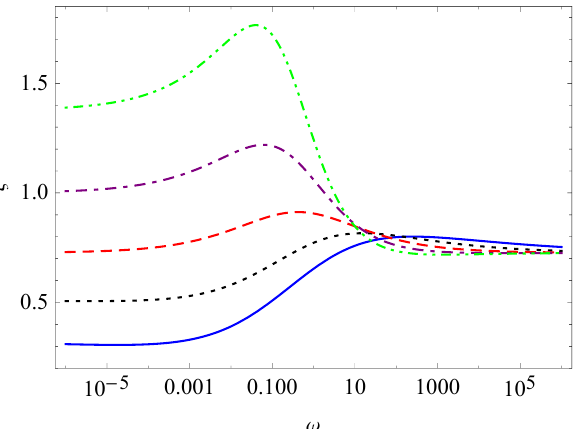
Figure 9. Curves of ζ ∼ ω for a = 1, b 1 = 1, b 2 = 2, and β − α = 0.4 and for α = 0.2 (solid line), 0.3 (dotted line), 0.4 (dashed line), 0.5 (dotted–dashed line), and 0.6 (dotted–dotted–dashed line) in the fractional five-parameter model (68).